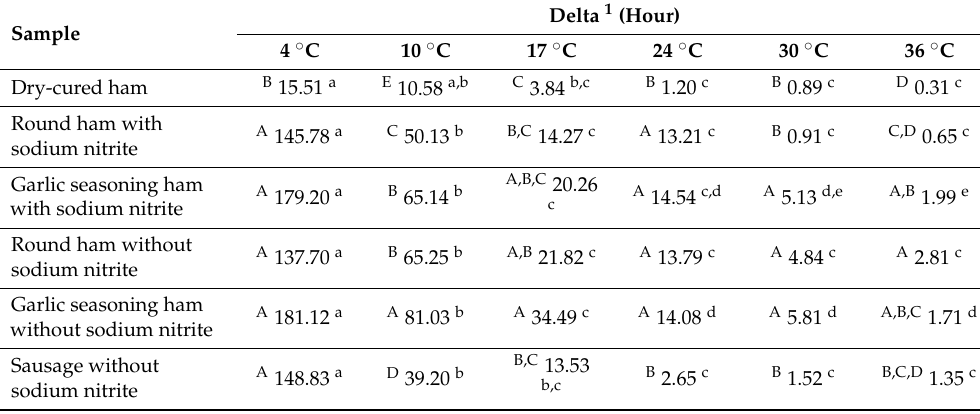
Table 3. Kinetic parameters (delta) for C. jejuni survival on various processed meat products as a function of